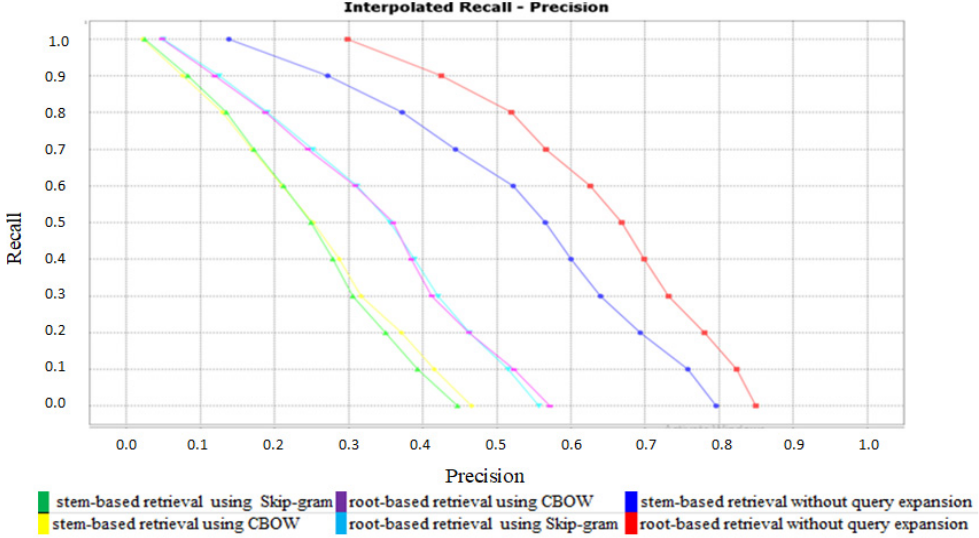
Figure 5. Recall-precision curves before and after query expansion using word